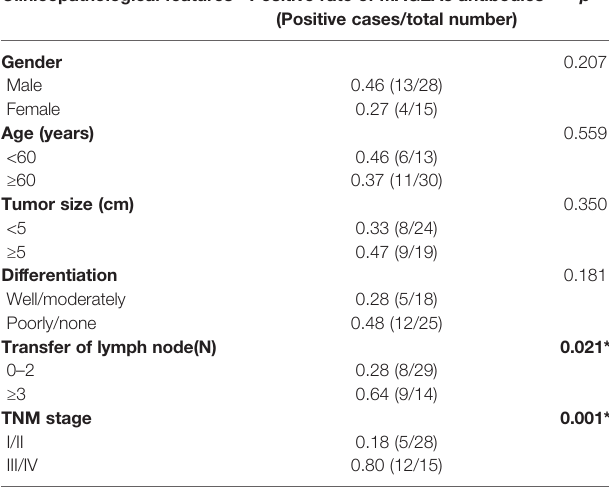
TABLE 3 | Clinicopathological features and MAGEA3 antibodies detection of 43